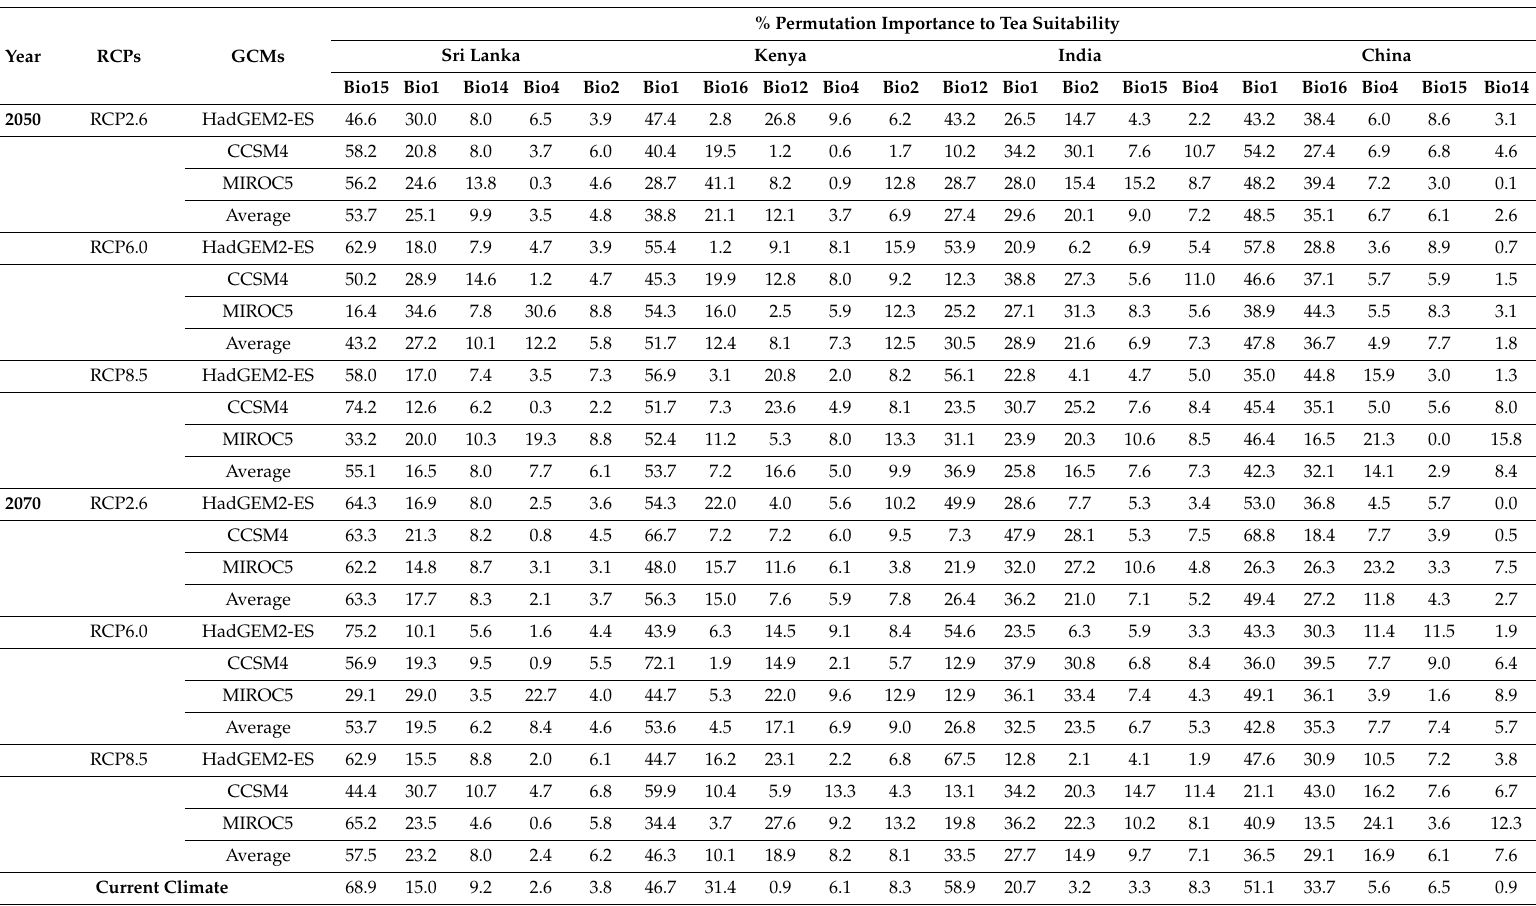
Table 2. Contribution of bioclimatic variables that a ff ect current and future suitability habitats of tea in the four tea-producing